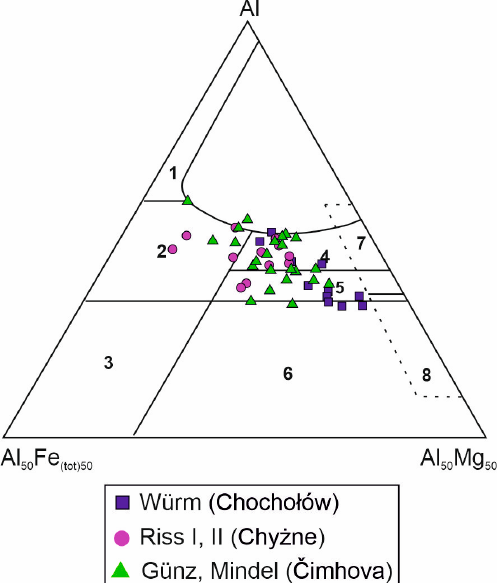
Figure 9. Provenance diagrams for tourmalines from the studied deposits: 1—Li-rich granitoids, pegmatites and aplites; 2—Li-poor granitoids, pegmatites and aplites; 3—hydrothermally altered, granitic rocks; 4—Al-rich metapelites and metapsammites; 5—Al-poor metapelites and metapsammites; 6—Fe 3+ -rich quartz-tourmaline rocks, calc silicates and metapelites; 7—Ca-poor ultramafites; 8—metacarbonates and metapyroxenites [65].